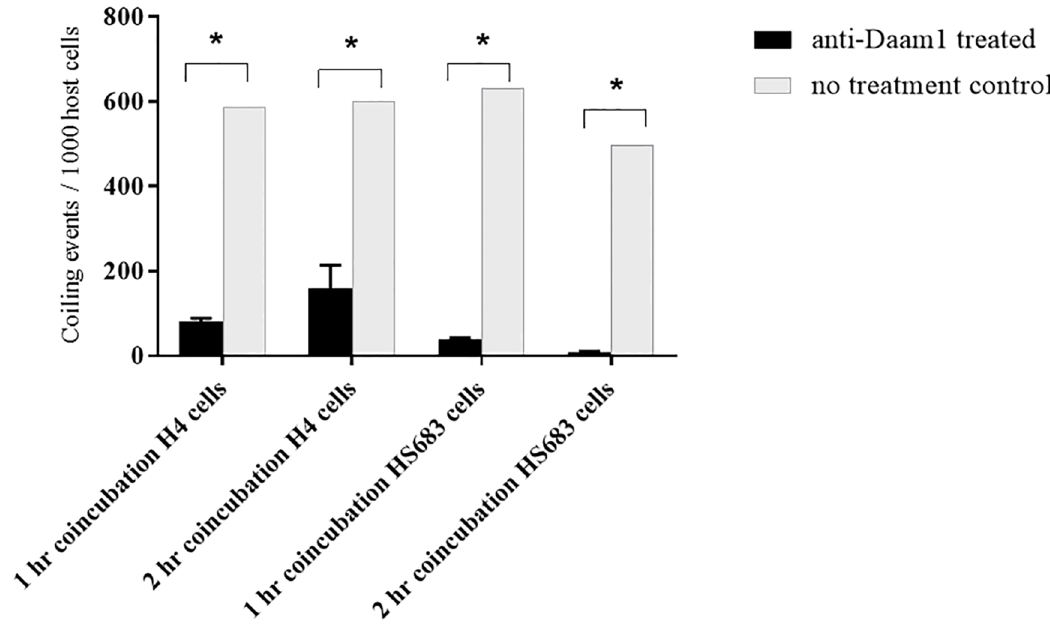
Fig 2. Anti-Daam1 antibody treatment of host cells reduces B . burgdorferi phagocytosis. Bars represent number of coiling events per 1000 host cells. Coiling event is defined as a host cell with a Daam1-stained pseudopod coiling around a B . burgdorferi cell. Asterisks denote P-value < 0.01 by Two-way ANOVA Sidak’s multiple comparisons test. Graphs represent the mean of all experiments.